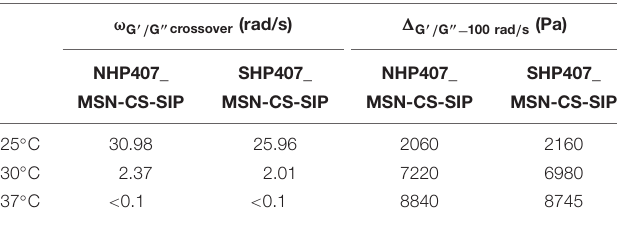
TABLE 3 | Frequency values at G (cid:48) /G (cid:48)(cid:48) crossover ( ω G (cid:48) / G (cid:48)(cid:48) crossover ) and G (cid:48) /G (cid:48)(cid:48) delta at 100 rad/s ( (cid:49) G (cid:48) / G (cid:48)(cid:48) _ 100 rad / s ) for NHP407_MSN-CS-SIP and SHP407_ MSN-CS-SIP evaluated at 25, 30 and 37 ◦ C.